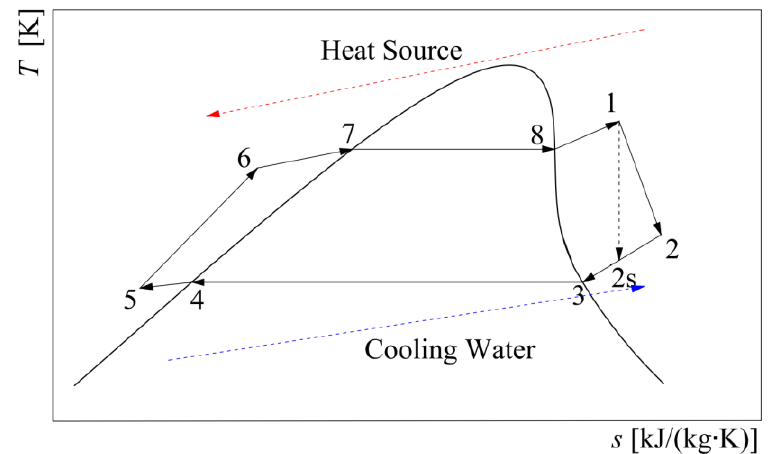
Figure 2. T-s diagram of the ORC.